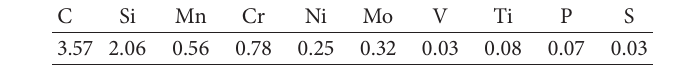
Table 1: Chemical composition of the GCI (wt.%).